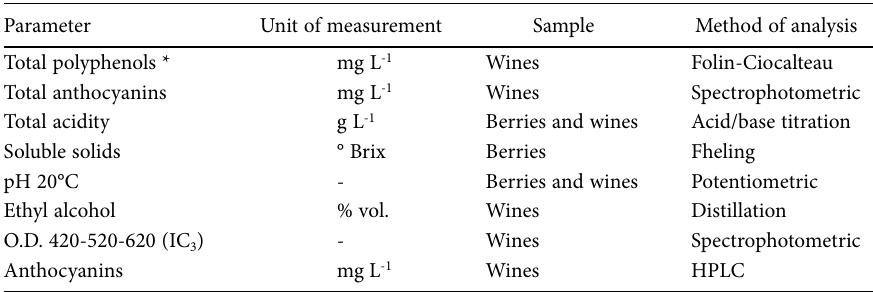
Table 6. Chemical analyses of cv. Montepulciano berries and wines obtained from vines treated with either Italian chabasite-rich zeolitites or synthetic fungicides and insecticides for control of grey mould, sour rot and grapevine